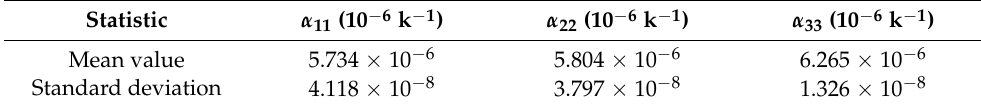
Table 12. The 2.5D material thermal expansion coefficient